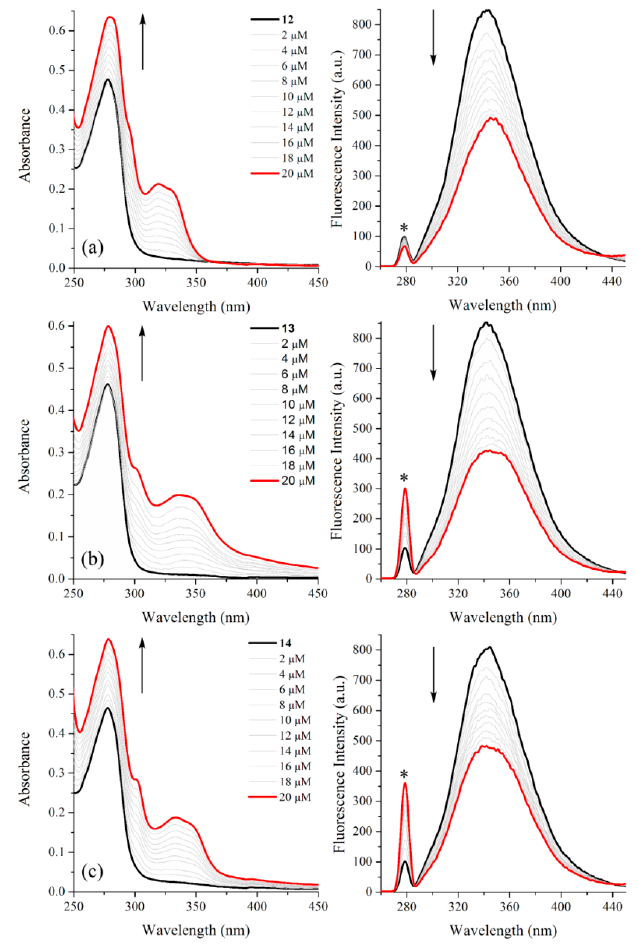
Figure 3. UV-Vis absorption (left) and steady-state fluorescence emission spectra (right) for BSA (11 µ M) in PBS (pH 7.2) in the absence and presence of different quantities (0 to 20 µ M) of compounds ( a ) 12 , ( b ) 13 , and ( c ) 14 . The asterisk indicates the excitation wavelength signal. (For emission spectra λ ex = 277 nm, slits Ex/Em = 5.0 nm/5.0 nm).